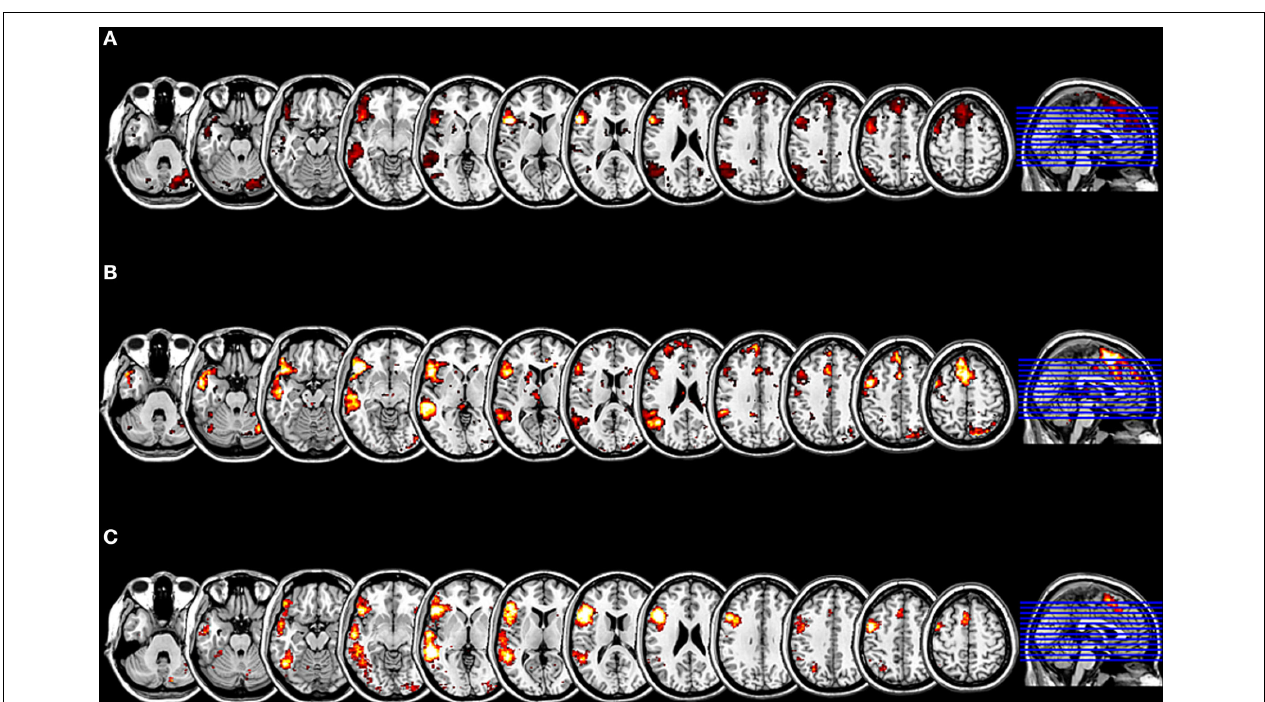
FIGURE 3 | Results of the evaluation of the functional plausibility of the language relevant RSN. (A) The cluster map for the SCA with seeds within the pars triangularis and the pars opercularis, with an extension threshold for clusters of p < 0 . 01 FEW. (B) The t-mask for the ICA generated component 22 thresholded at p < 0 . 01 FDR. The SCA cluster map and the component 22